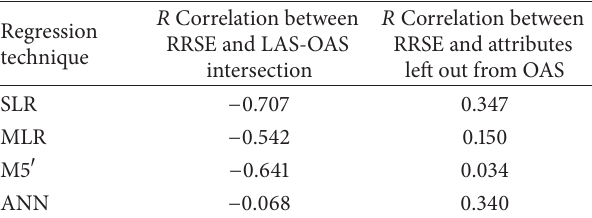
Average Table 11: Correlation coefficient between the counts of attributes in LAS-OAS intersection and RRSE. 𝑅 Correlation Regression technique